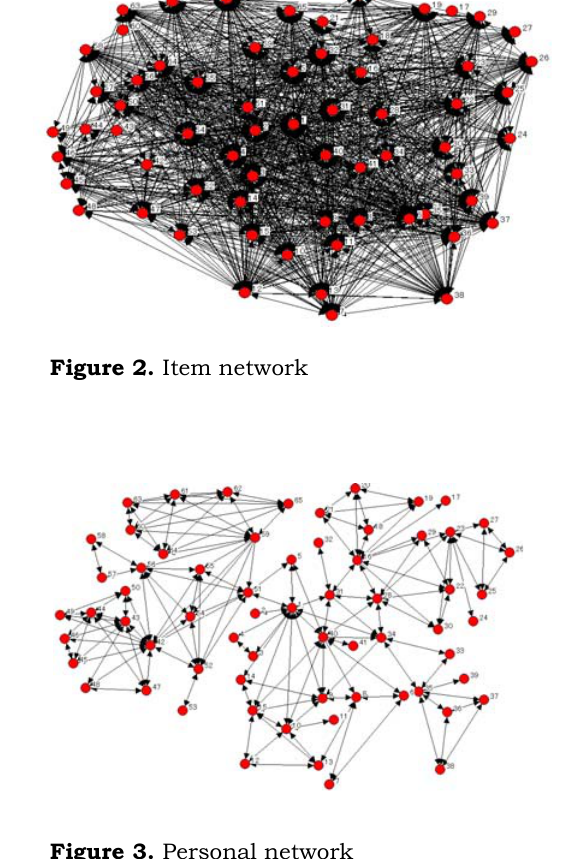
Figure 3. Personal